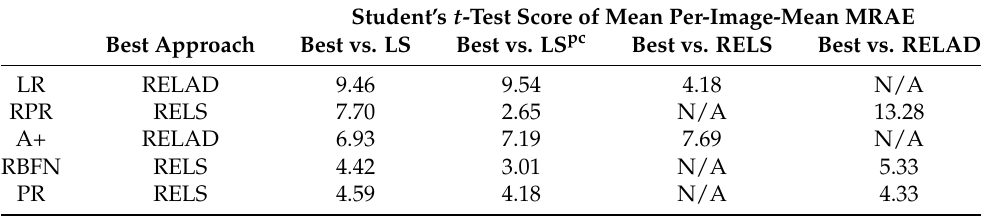
Table 4. The paired two-sample Student’s t -test scores of the mean per-image-mean MRAE results. For each regression model, the best minimization criterion (the one has the lowest number in Table 3) is tested against each of the other